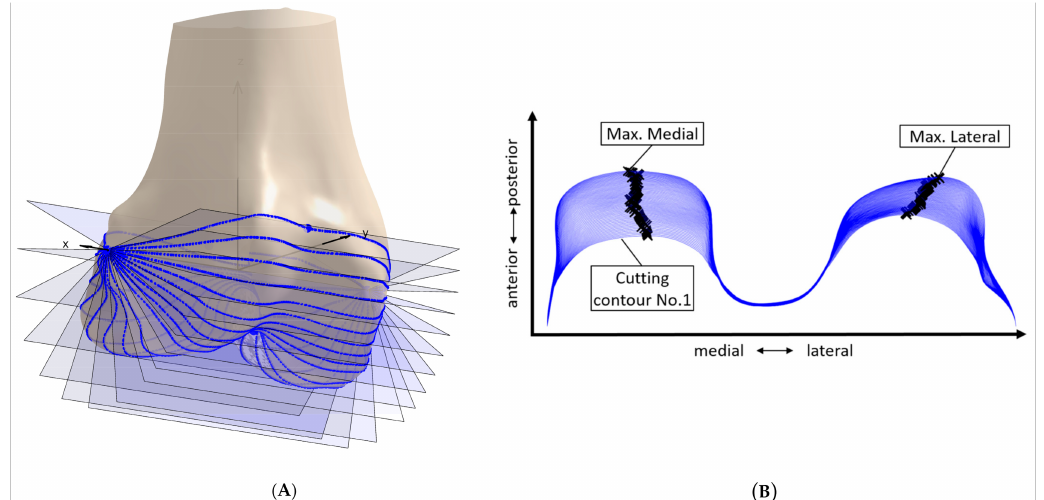
Figure 1. Elements of the process of contour derivation. ( A ) Example femur with rotating cutting planes for the derivation of cutting contour (note: only 18 cutting planes displayed here, to enable better visualization of the individual planes). ( B ) Cutting contours (blue) and extrema (black) for cutting planes 1 to